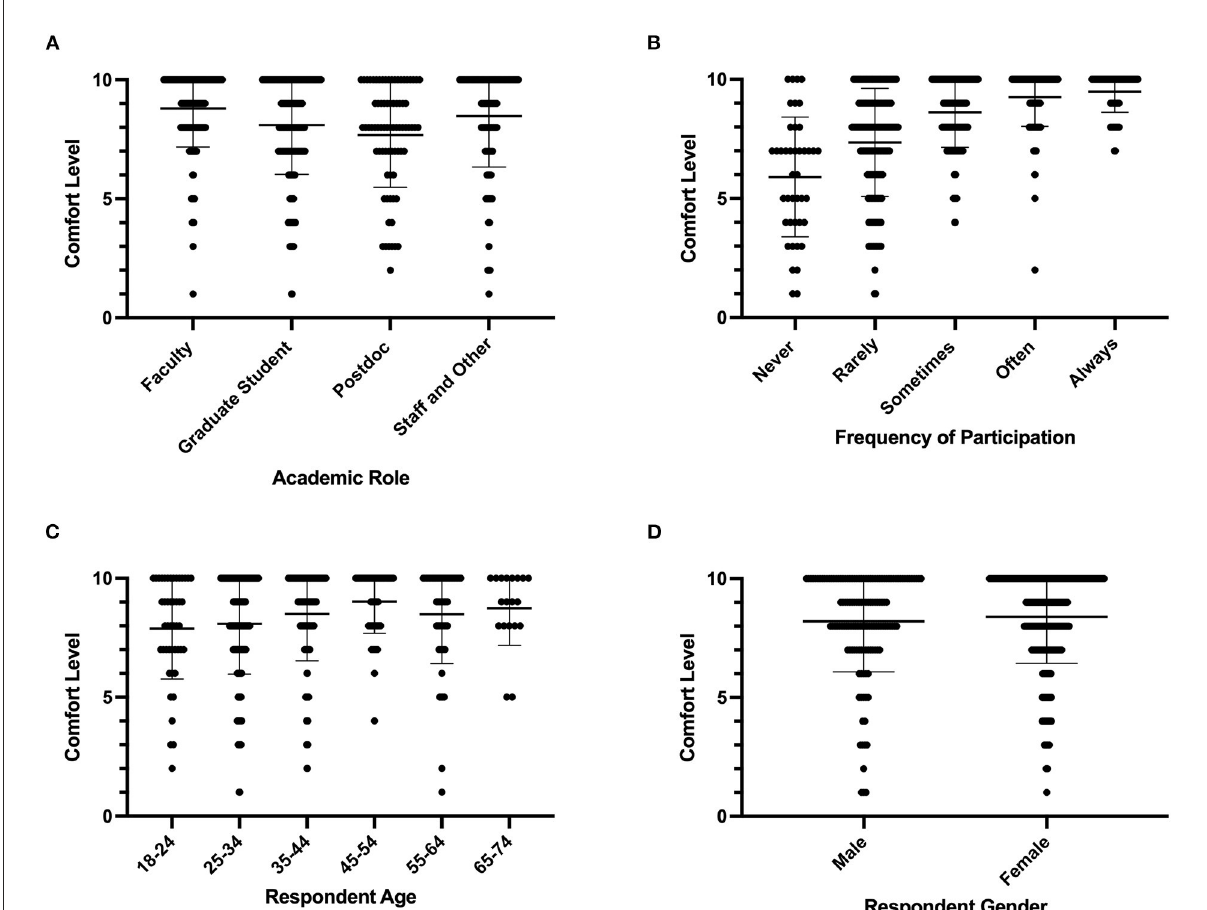
FIGURE3 Comparison of respondents’ comfort level participating in science outreach activities. Respondents comfort level (1 – not being comfortable at all to 10 – being very comfortable) participating in science outreach significantly differed by (A) academic role [ H = 21.27, p = 0.0003, n = 530)], (B) how often they participate in outreach levels [ H = 137.5, p < 0.0001, n = 530], and by (C) age [ H = 15.1, p = 0.019, n = 530]. (D) Respondents’ comfort level participating in outreach did not differ by gender [ H = 8.41, p = 0.07, n =